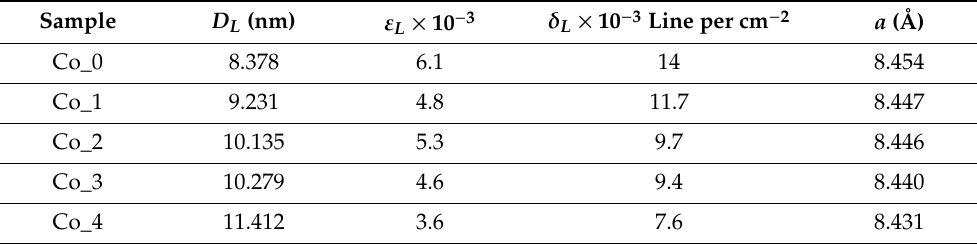
Table 1. The calculated values of the crystallite size ( D L ), the micro-strain ( ε L ), the dislocation density ( δ L ) and the lattice parameter ( a ) of Co_ (0–4) ferrite